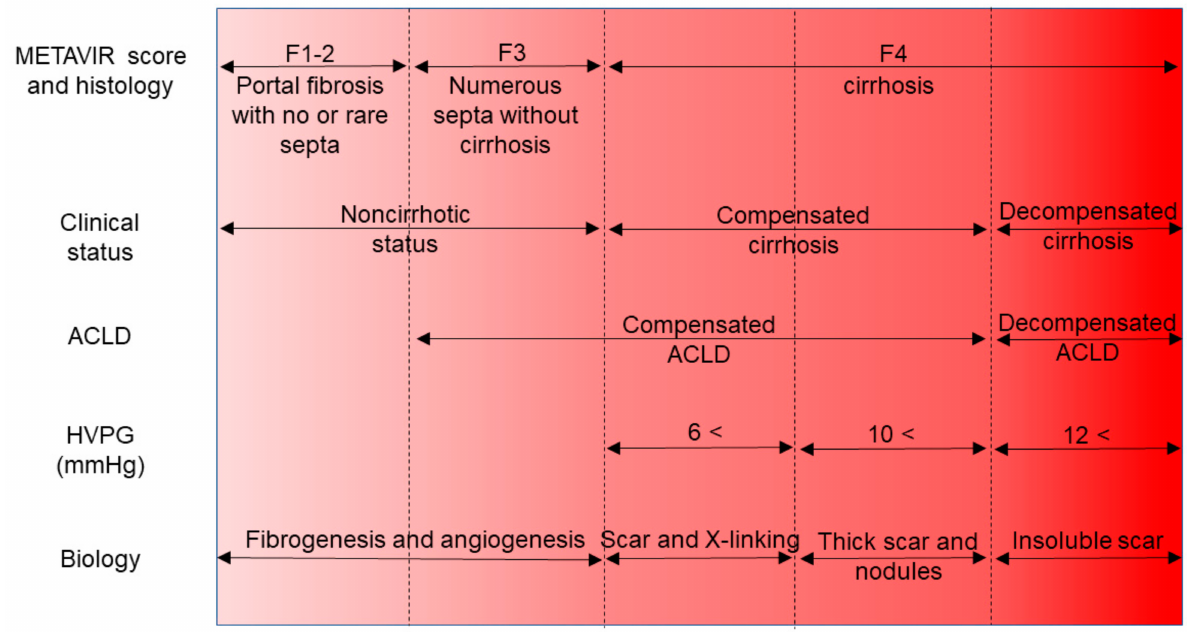
Figure 1. Contrast of the fibrosis stage, clinical definition, and